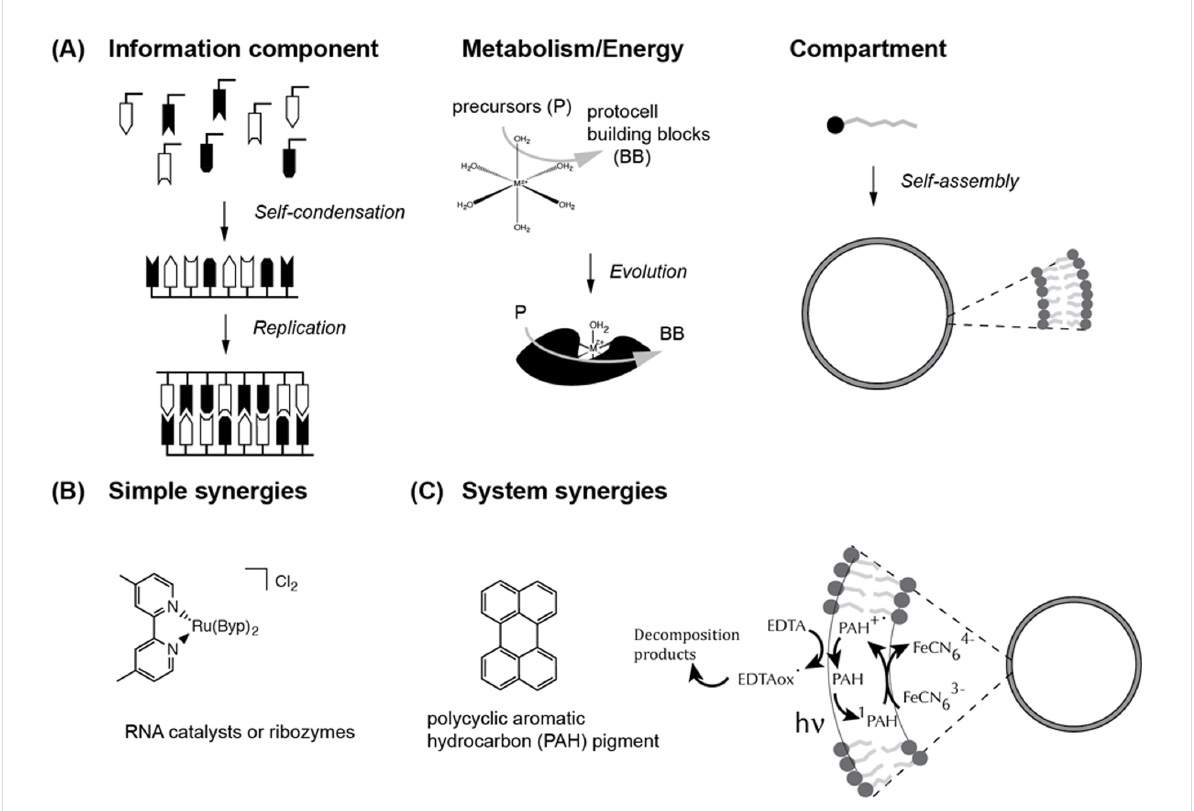
Figure 2: The bottom-up approach research strategies. (A) Each protocell component (vide infra) can be investigated in “isolation” to better under- stand the various processes pertaining to its synthesis/formation: information polymer, functional catalysts or self-assembly/stability of the compart- ment. (B) A higher degree of complexity can be attained by using chemicals that by themselves already link to two component functions: for instance, metal complexes that can harvest light (here a ruthenium tris(bipyridine) and catalyse reactions, or polymers such RNA ribozymes that are both geno- type (information component) and phenotype (catalyst). (C) The systems approach offers insight into the increased level of cooperativity necessary to grasp the complexity of living interactions. The creation of chemical gradients, for example, requires the presence of a compartment and an energy harvesting system. In the case of PAHs, which are sparingly soluble in water, the compartment boundary not only allows for a distinction between two aqueous volumes, it also increases the availability of the PAH molecules by providing a specific hydrophobic environment for their solubilization, thereby improving the energy